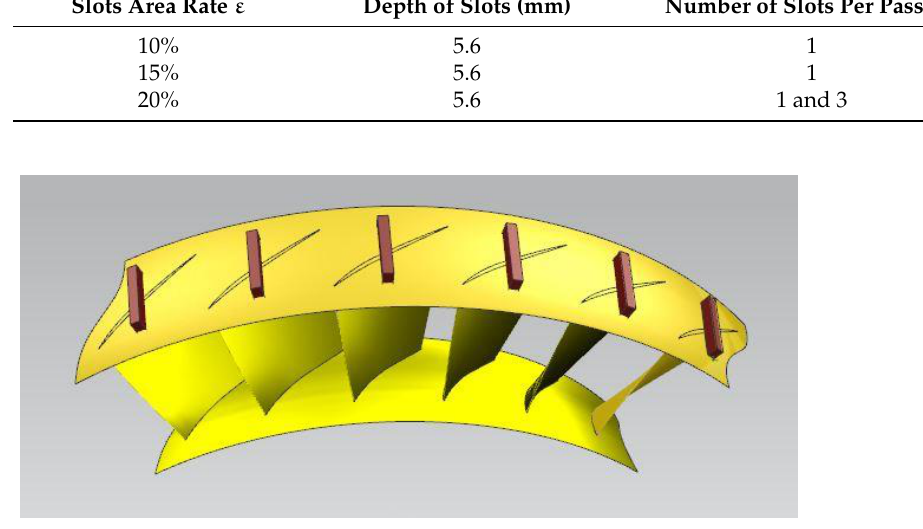
Figure 2. The model of the novel axial slot casing treatment.